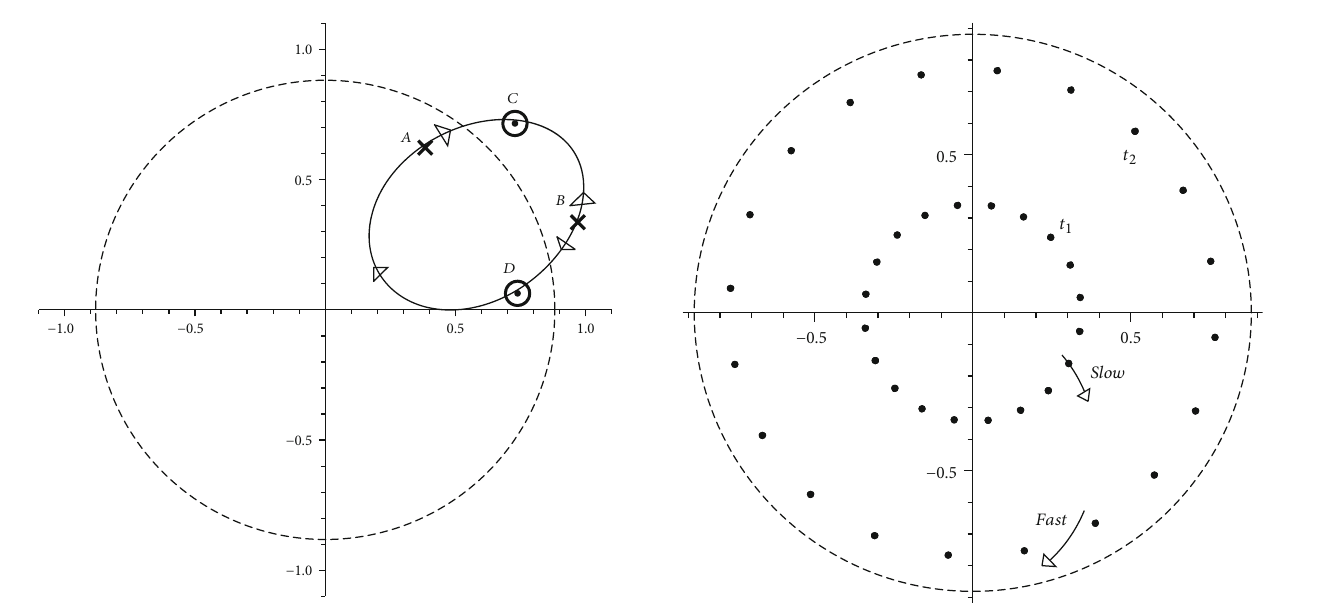
Figure 4: Points on the wave front of null geodesics emitted from the origin in the Gödel metric. The wave fronts are circles that expand to the limiting circle and rebound. The points on the wave front rotate demonstrating the Gödel metric ’ s rotational